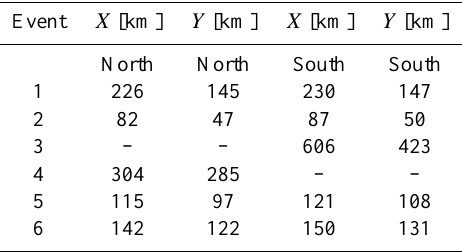
Table 7. Travel time in seconds reach approximately 3.6 R E to- wards each hemisphere. t N and t S represent travel time to the North- ern and Southern Hemisphere,